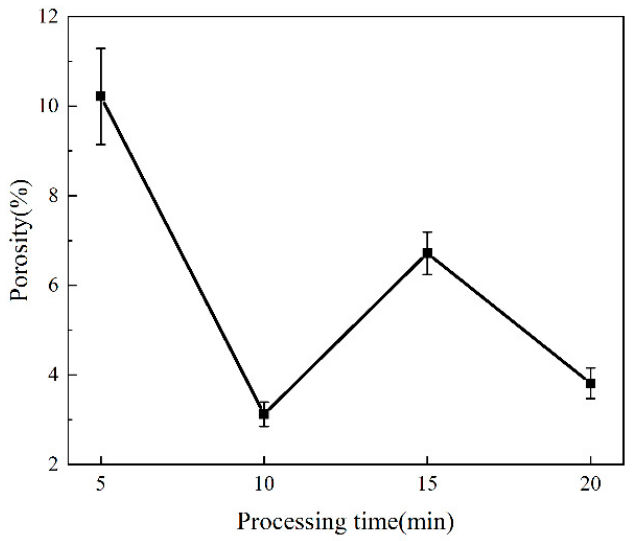
Figure 2. Porosity change of MAO coatings at different treatment times.